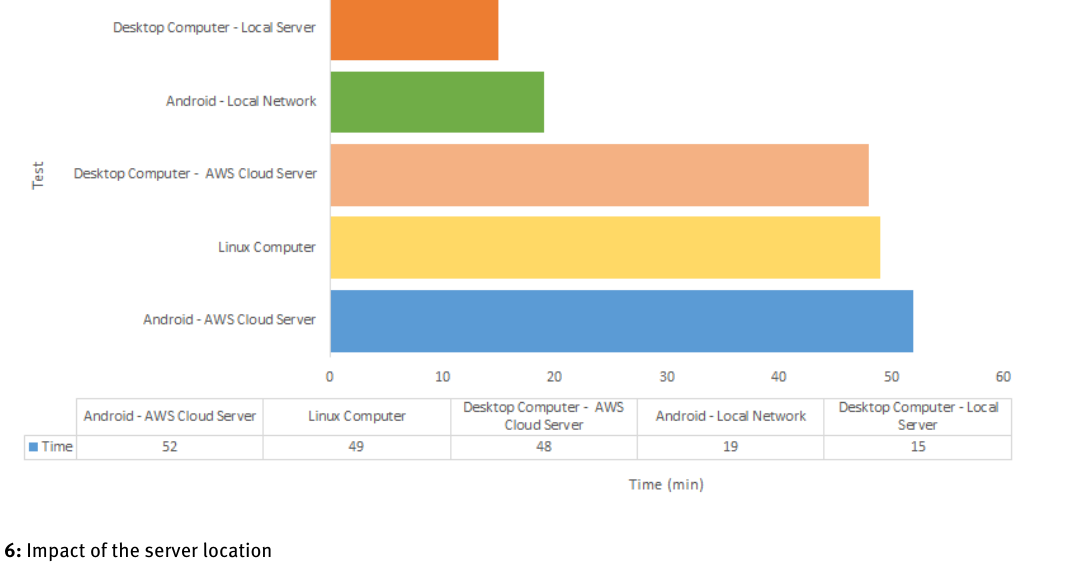
Figure 6: Impact of the server location